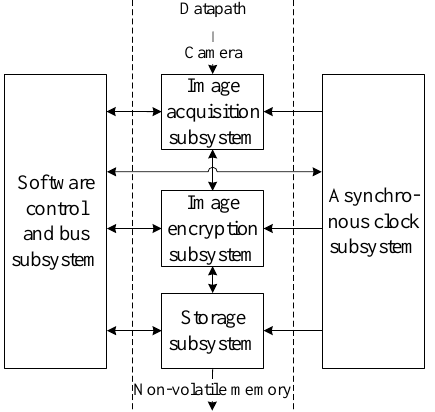
Figure 21. Connection relationship in SoC